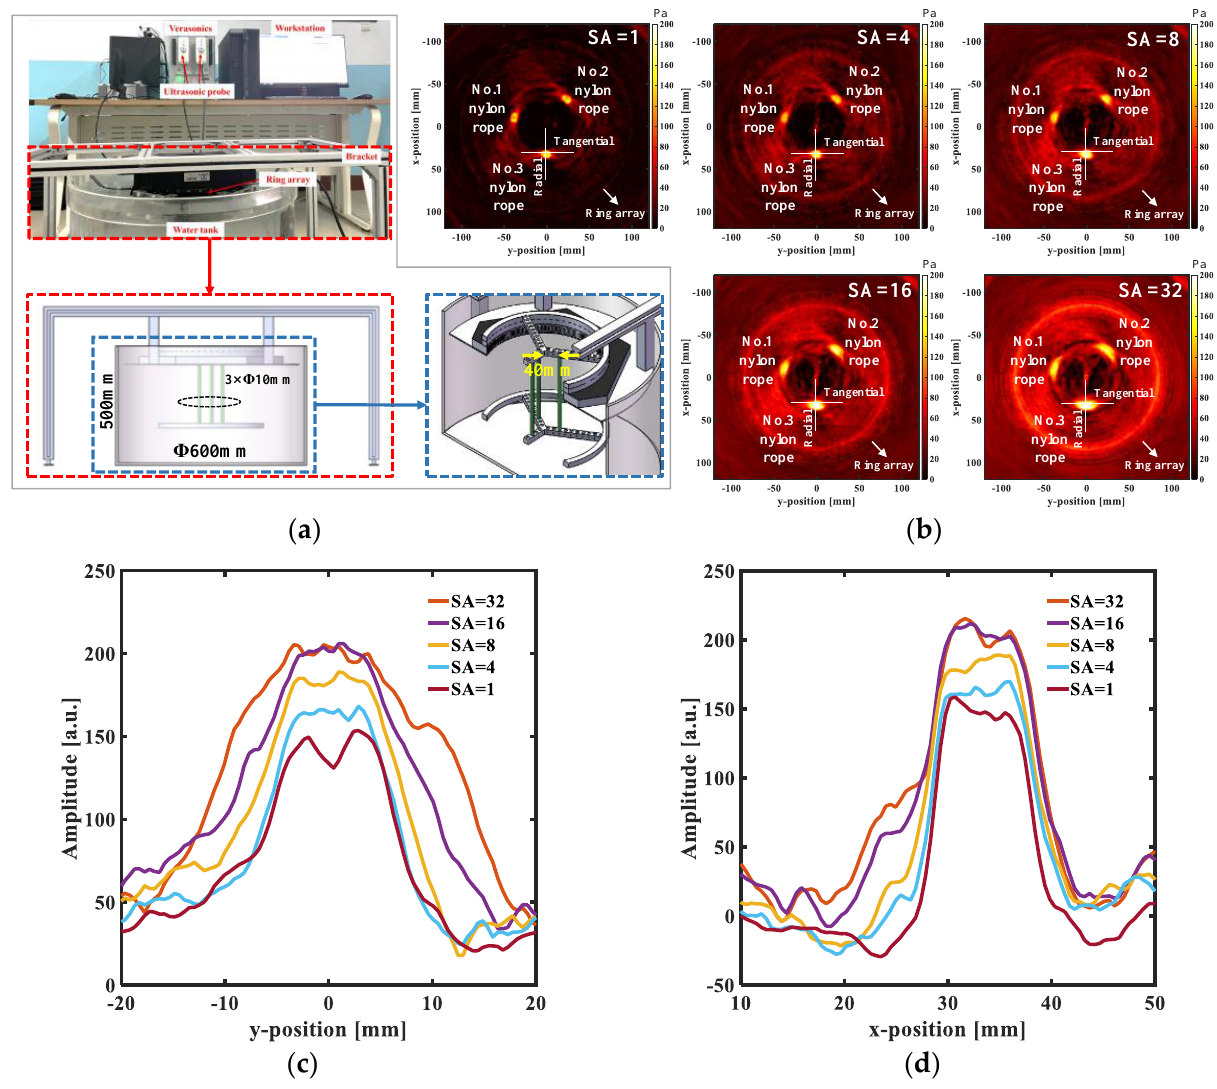
Figure 6. US imaging of the nylon rope based on M-SAF (SA = 1, 4, 8, 16, 32). ( a ) US imaging system and partial three-dimensional modeling. ( b ) Reconstruction results of the nylon rope ultrasonic imaging. ( c ) Radial sound pressure amplitude detection of the nylon rope in the reconstructed image. ( d ) Amplitude detection of the tangential sound pressure value of the nylon rope in the reconstructed image. M-SAF: multi-element synthetic aperture focusing; US: ultrasonic imaging; SA: synthetic aperture.